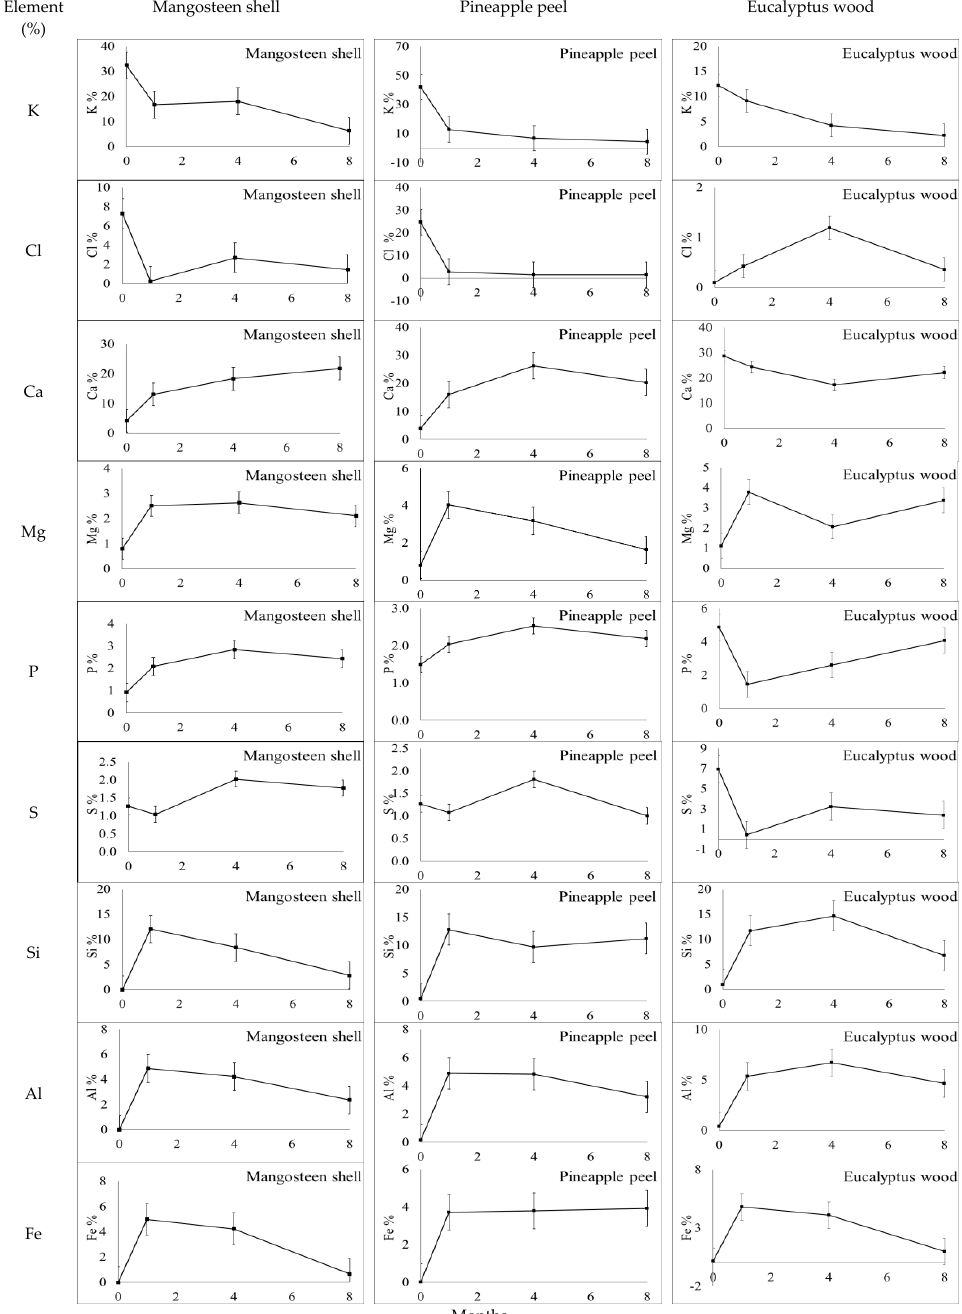
Figure 5. Semiquantitative elemental analyses of fracture surfaces of three biochars recovered after zero, 1, 2, 4, and 8 months of incubation in the soil. Values are average and SD for nine soils. The lower limit of SD values extend to negative values for K and Cl in pineapple peel biochar, which is a consequence of the SD values being large compared to the average values.